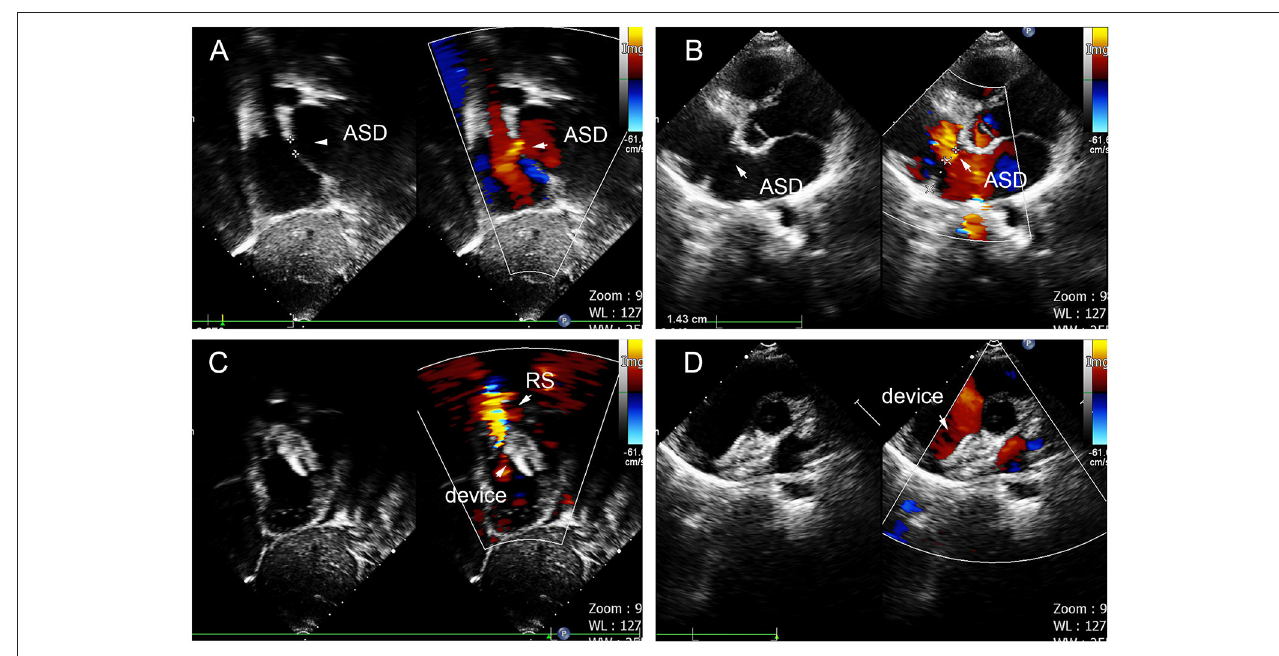
FIGURE 10 | Double defects in the atrial septum (A,B) , and there remained residual shunt at last follow-up (C,D) . ASD, atrial septal defect; RS, residual shunt.